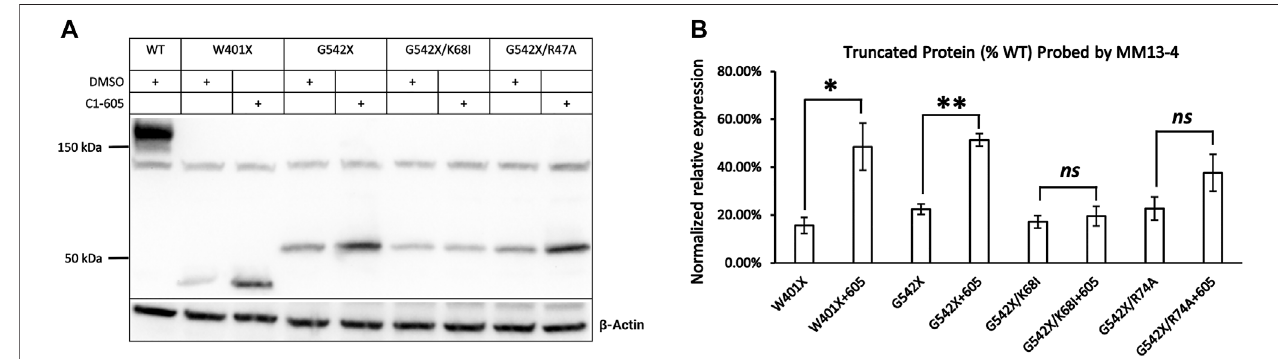
FIGURE4| WesternblotanalysisoftheexpressionoftheC-terminustruncatedproteinofW401X-,G542X-,G542X/K68I-,andG542X/R74A-CFTR. (A) Effectsof type1corrector605ontheexpressionofC-terminustruncatedproteinofW401X-,G542X-,G542X/K68I-,andG542X/R74A-CFTR.ThegelwasprobedwithantiCFTR N-terminal antibody MM13-4. DMSO was used as vehicle control for lanes 1, 2, 4, 6, and 9. (B) Quanti fi cation of the expression of the C-terminus truncated protein of W401X-, G542X-, G542X/K68I-, and G542X/R74A-CFTR compared to WT-CFTR. Data are represented as mean ± SEM. The asterisks indicated a signi fi cant increase of the expression in C-terminus truncated protein by type 1 corrector C605 when compared with that of DMSO (N = 3, paired t -test). * p < 0.05; ** p < 0.01. ns presents no signi fi cant